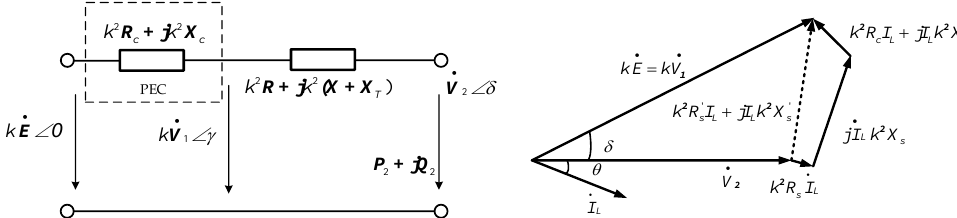
Figure 12. Equivalent circuit and phasor diagram of Flexible OLVR transformer based on controllable impedance equivalent.